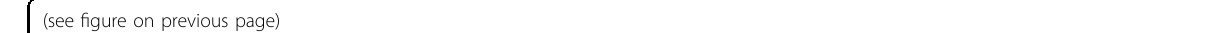
Fig. 3 EphA2 mediates proliferation, migration, invasion, and sorafenib sensitivity. a HuH-7 R cells were infected with lentiviruses containing shEphA2 (#1, #2) or control shRNA (shCtrl) and, 48 h later, were lysed and analyzed by western blotting with the indicated antibodies. b The viability of EphA2 knockdown HuH-7 R cells was determined at the indicated time points with the MTT assay. The plots depict cumulative cell numbers versus days in culture. c The tumorigenicity of EphA2 knockdown HuH-7 R cells was determined using the soft agar colony-formation assay. d Wound- healing assay of shEphA2-infected HuH-7 R cells. The micrographs show cells that migrated into the gap 0 and 24 h after the removal of the insert. e Transwell invasion assay of shEphA2-infected HuH-7 R cells. Cells in the central fi eld of each insert were visualized via light microscopy and quanti fi ed. f HuH-7, shCtrl, and shEphA2-containing HuH-7 R cells were exposed to sorafenib at the indicated concentrations for 72 h, and cell viability was analyzed with the MTT assay. The concentration – response curve for sorafenib in the EphA2 knockdown group shifted toward a lower concentration compared to that for shCtrl-infected HuH-7 R cells. All statistical data were calculated from three independent replicates (** p < 0.01; *** p < 0.001; shCtrl control shRNA, shEphA2 shRNA against